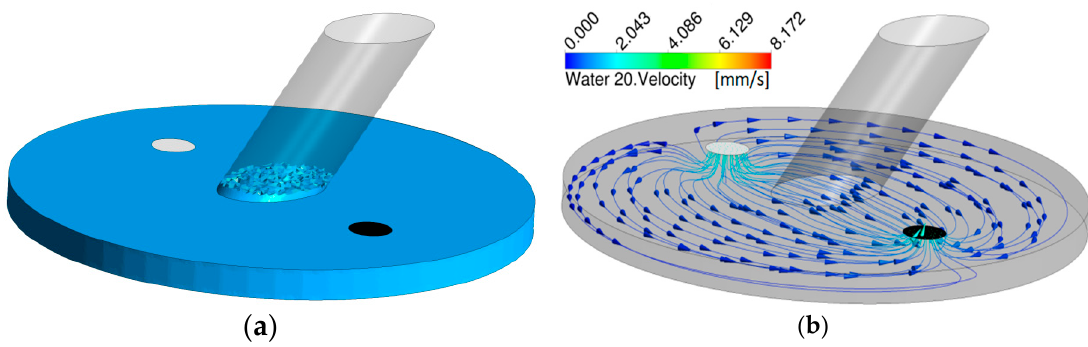
Figure 2. Surface level ( a ) and velocity streamlines ( b ) from inlet (white) to outlet (black) after 100 s. The final base of the microfluidic system was CNC milled in polycarbonate (PC).